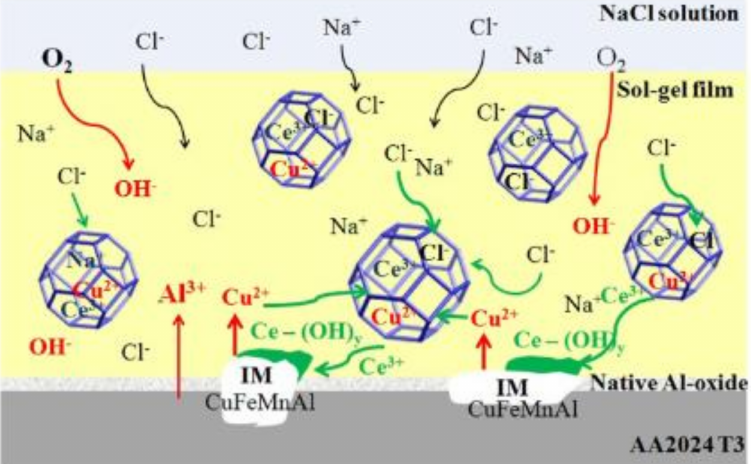
Figure 13. Representation of the mechanism of inhibitor release in the ion exchange process. Reprinted with permission from Ref. [64]. Copyright 2013, Elsevier.